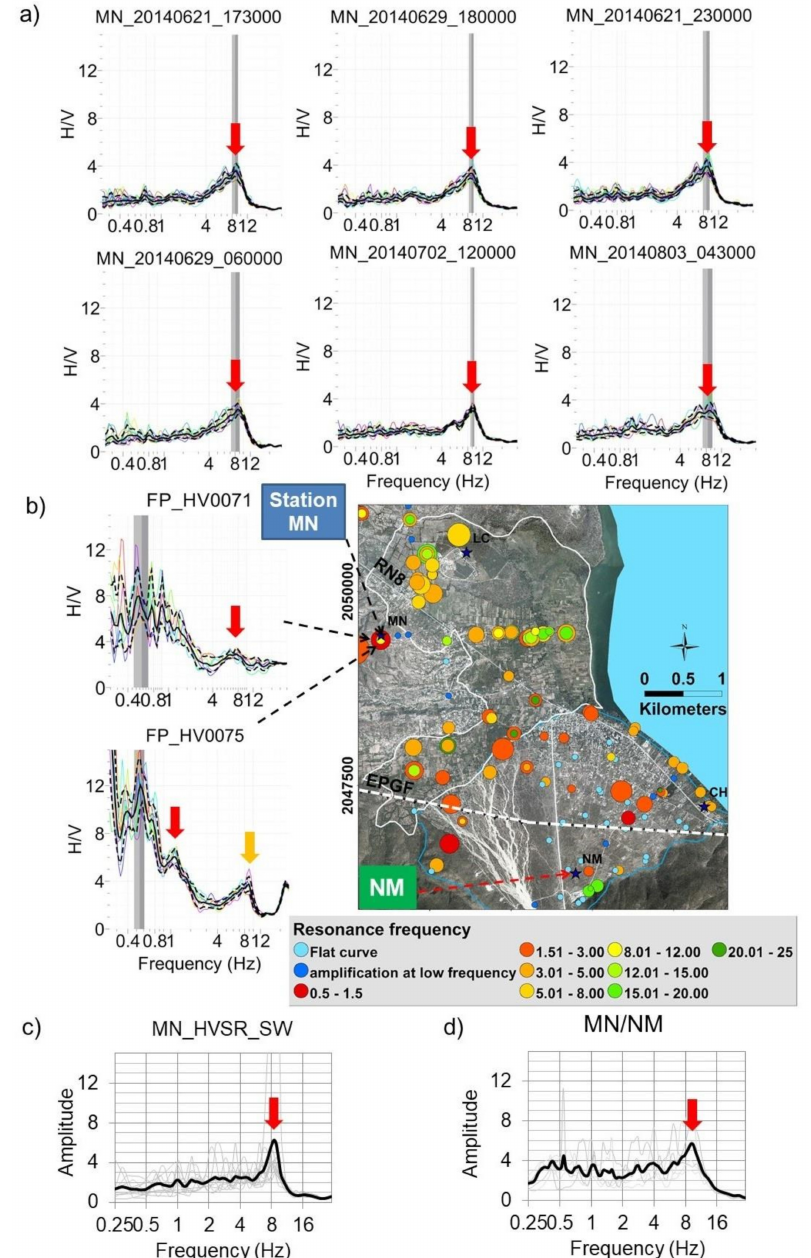
Figure A1. Spectral ratio curves computed for the MN site located near the western border for the sedimentary basin (the map, with white solid line delimiting the sedimentary basin, shows the HVSR results for that zone in terms of resonance frequencies and amplitude as colored circles of different sizes; see also Figure 7 for scales): ( a ) ambient noise HVSR curves for station MN records; ( b ) Tromino ambient noise HVSR curves; ( c ) and ( d ) respectively the earthquake HVSR and SSR curves (the latter using S-wave window spectra of NM station as reference). Red arrows indicate the fundamental resonance frequency; the orange arrow marks a second peak (at 8 Hz) in one Tromino ambient noise HVSR that corresponds to the fundamental peak on the other spectral ration